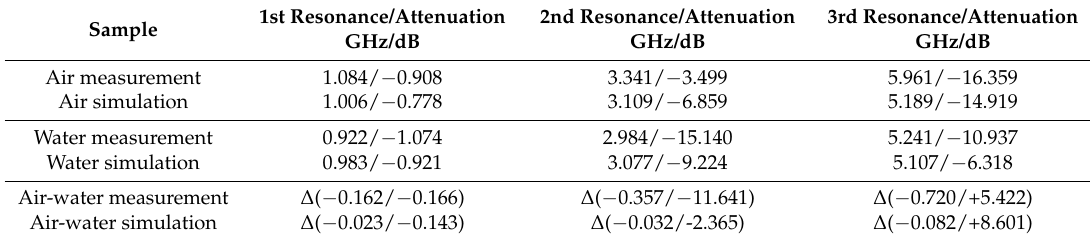
Figure 8. Simulation vs. measurement: ( a ) 1st resonance; ( b ) 2nd resonance; ( c ) 3rd resonance. Table 2. Corresponding frequencies in the simulation model vs. the measured frequencies.